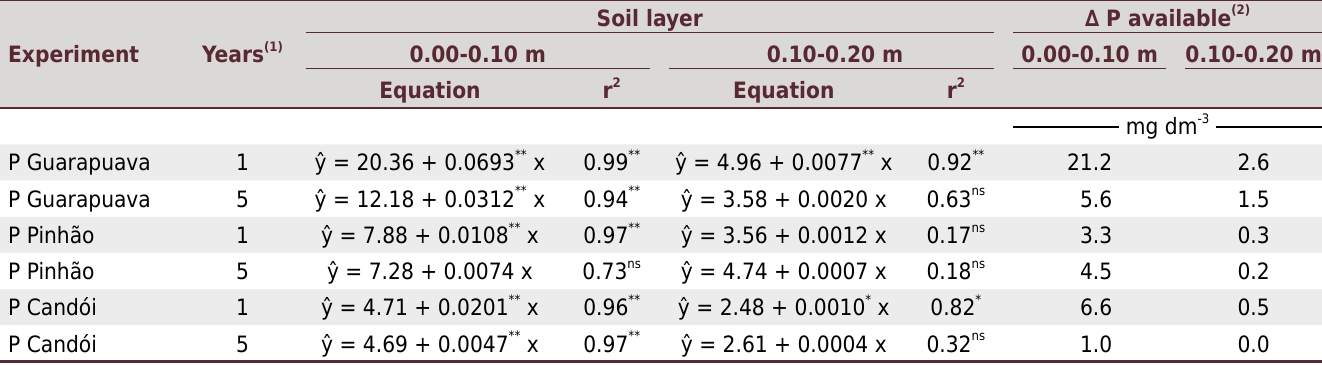
Table 3. Relationship between applied P 2 O 5 rates and increase of available P in two soil layers of Humic Hapludox soils at different times after application in long-term no-tillage experiments